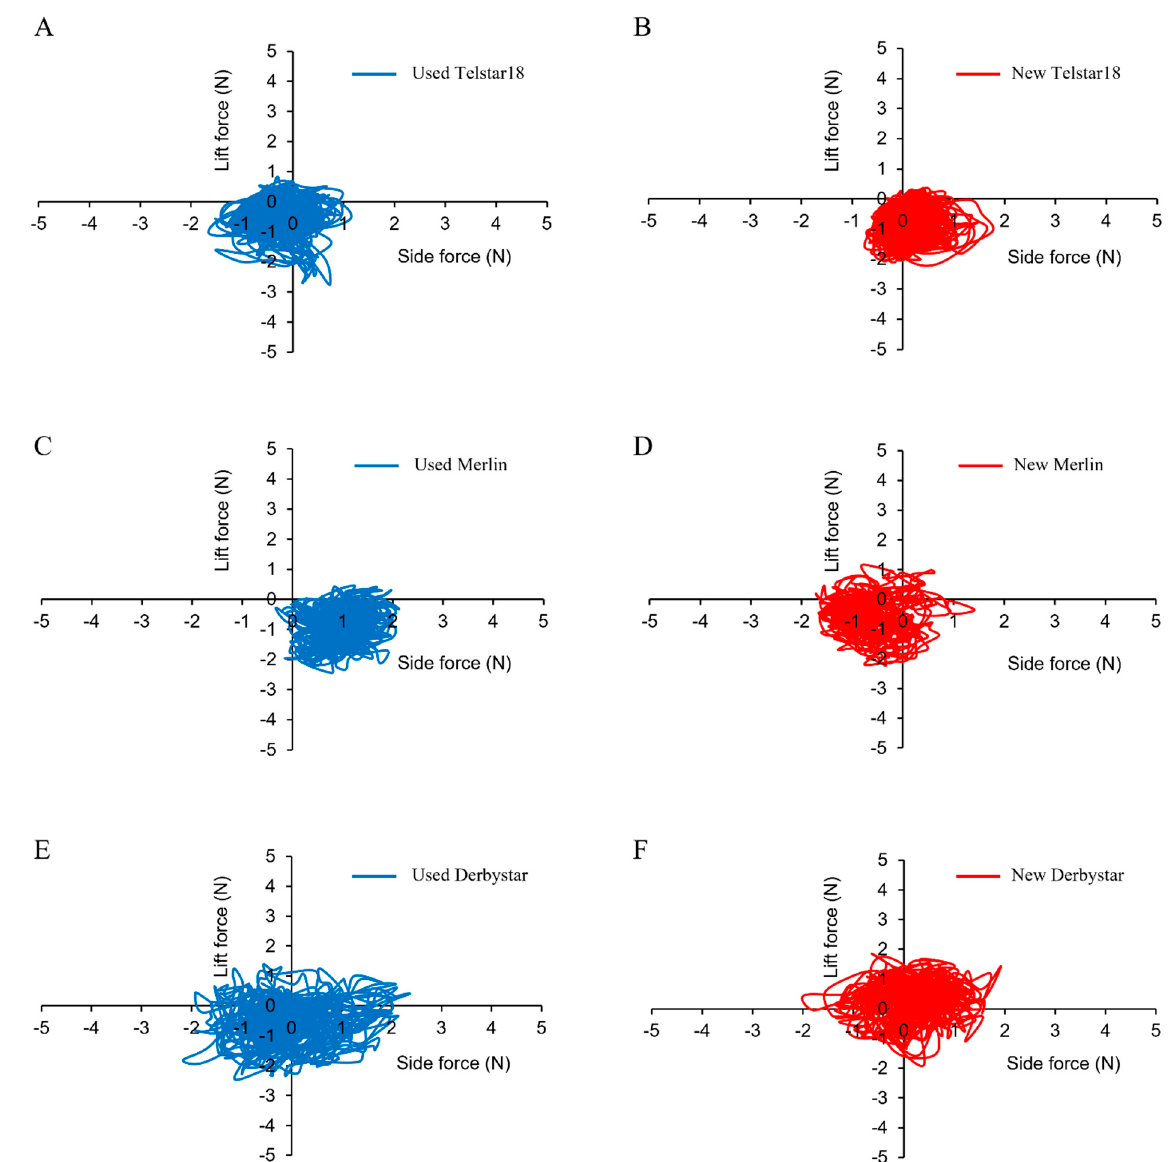
Figure 5. Changes in the lift and side forces of each soccer ball (airspeed 20 m/s, 10 s interval). ( A , C , E ) are the Telstar 18, Merlin, and Derbystar used balls, respectively. ( B , D , F ) are the Telstar 18, Merlin, and Derbystar new balls, respectively.